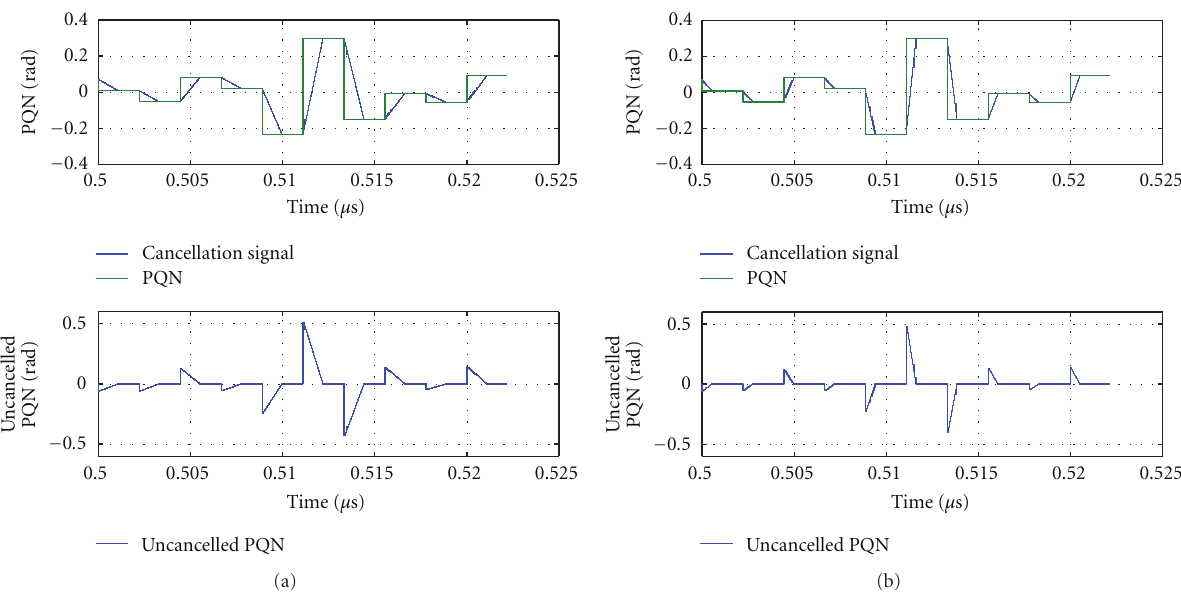
Figure 9: Timing diagram for PQN cancellation technique for (a) integration time of T s / 2 and (b) integration time of T s / 4, within each time period.